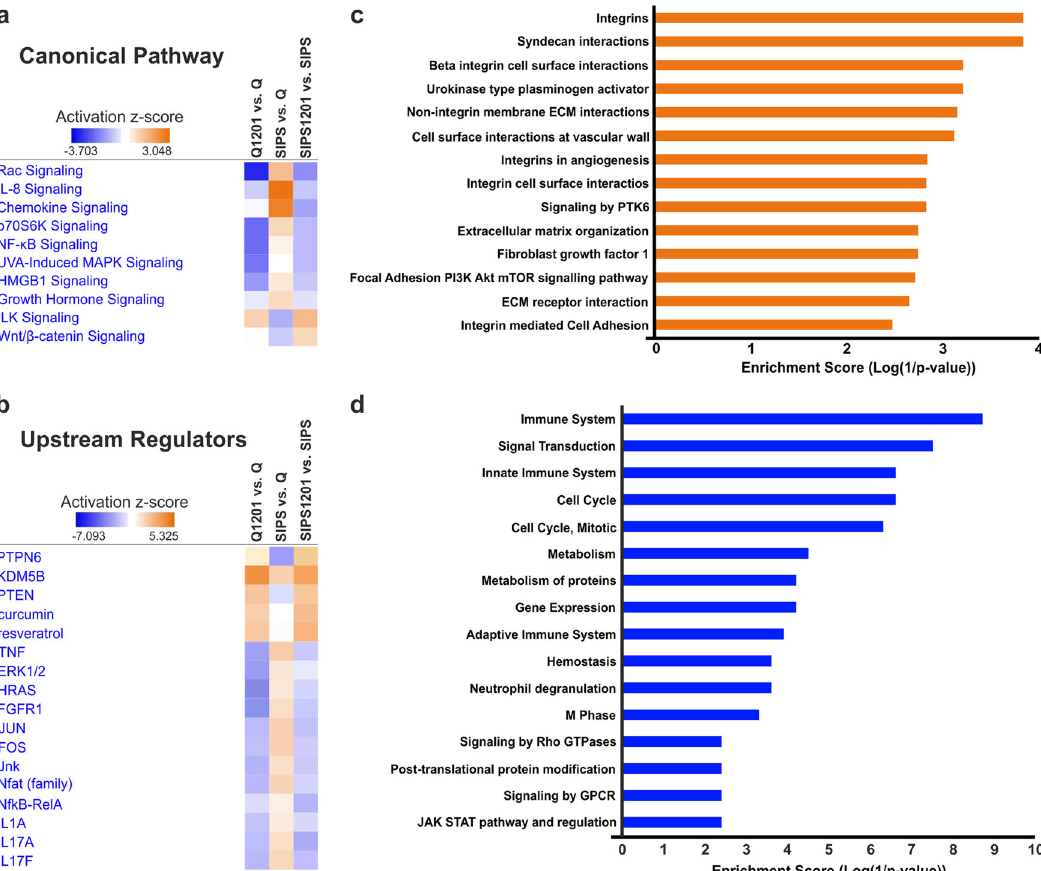
Fig. 5 Analysis of pathways and upstream regulators affected by 1201 treatment. a List of selected canonical pathways and b upstream regulators derived from Ingenuity pathway analysis of RNA-Seq data (for complete lists refer to Supplementary Tables S2 and S3). c Pathway enrichment analysis of genes upregulated by 1201 in both, Q and SIPS cells, and d of genes downregulated by 1201 in SIPS cells. Gene expression levels were derived from RNA-Seq data. From a to d , data represent the average of three